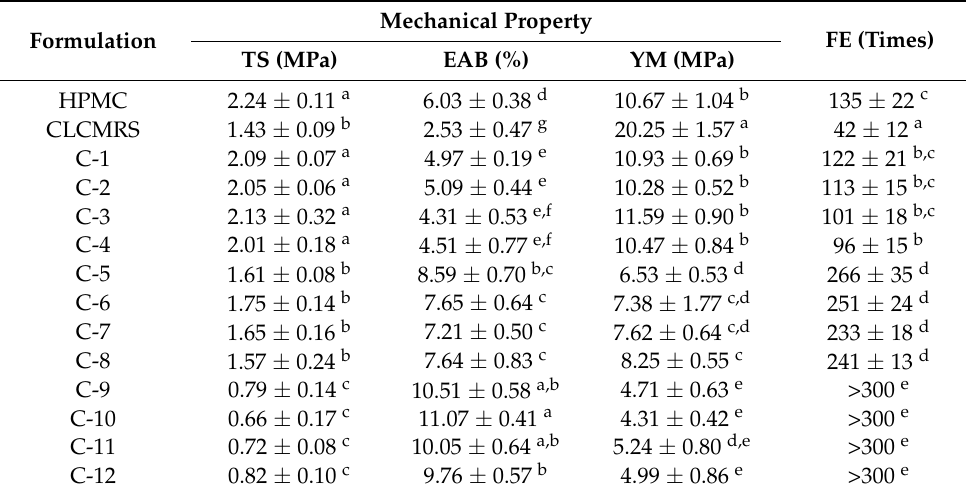
Figure 5. Representative stress-strain curves of the plasticized HPMC-CLCMRS composite films (C-5 to C-8) compared to that of HPMC film. Table 4. Mechanical properties of orodispersible films prepared with HPMC-CMRS composites at different ratio* .